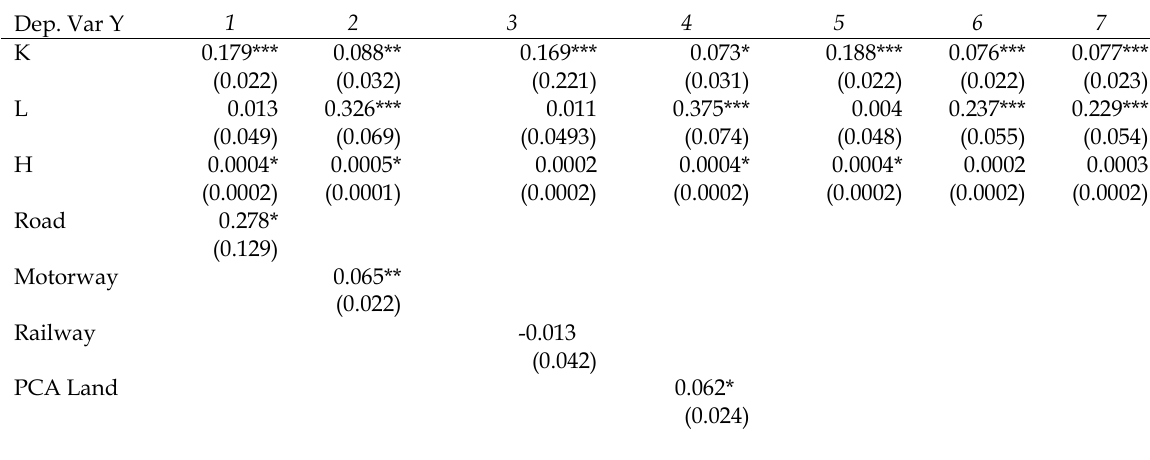
Table 7. Results of the Hausman-Taylor IV estimation Dep. Var